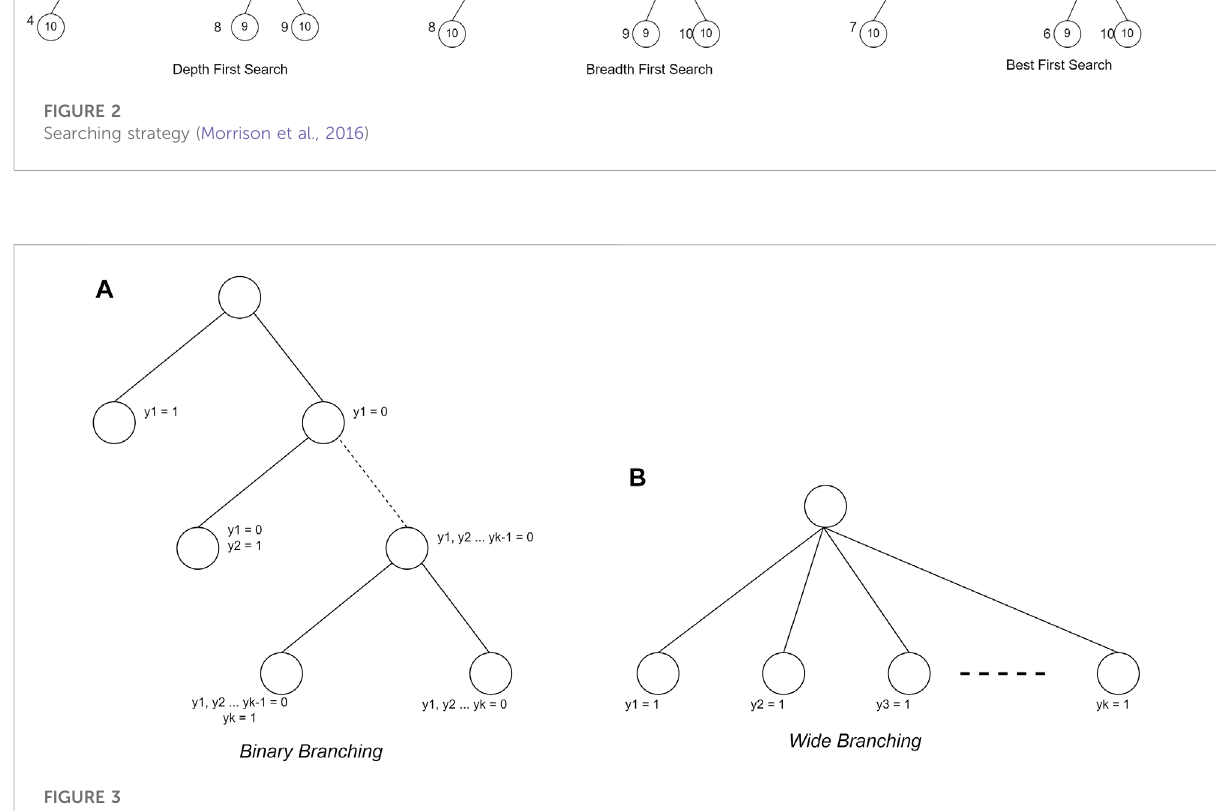
FIGURE 3 Branching strategy (Morrison et al.,